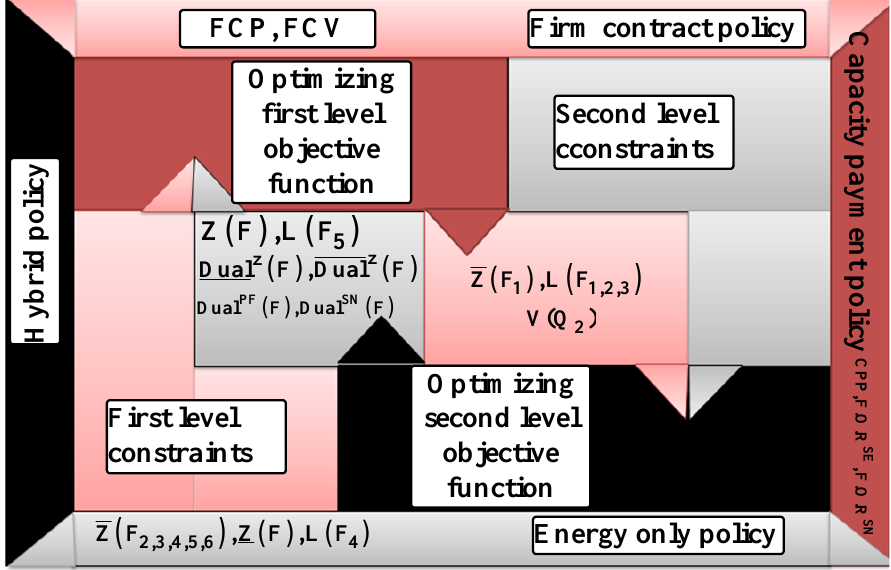
Figure 4. Relationship between the different levels and variables related to each